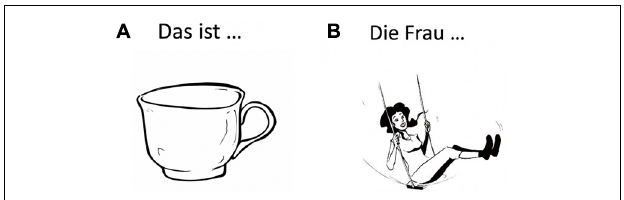
FIGURE 1 | Example stimuli for (A) Object Naming (“Das ist eine ... Tasse”: “This is a cup,” noun and article in German inflected for number, gender and case) and (B) Action Naming (“Die Frau ... schaukelt”: “The woman swings,” verb in German inflected for person, number and tense). See (Ohlerth et